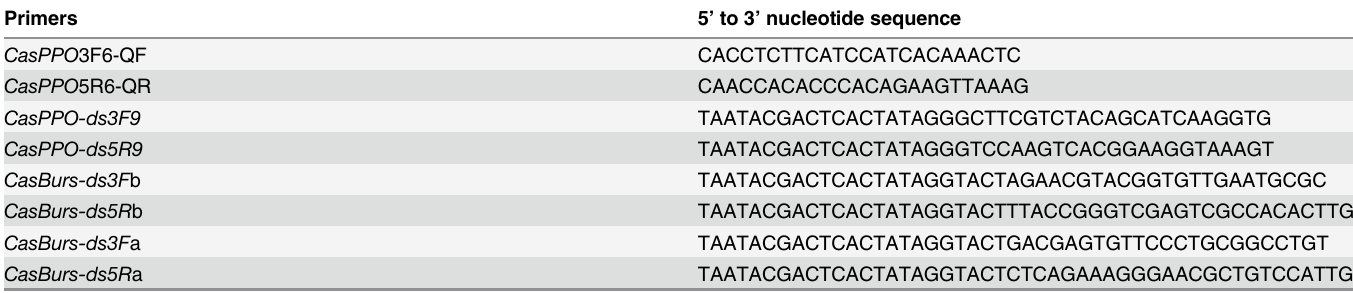
Table 2. List of primers used for dsRNA template amplification and qPCR